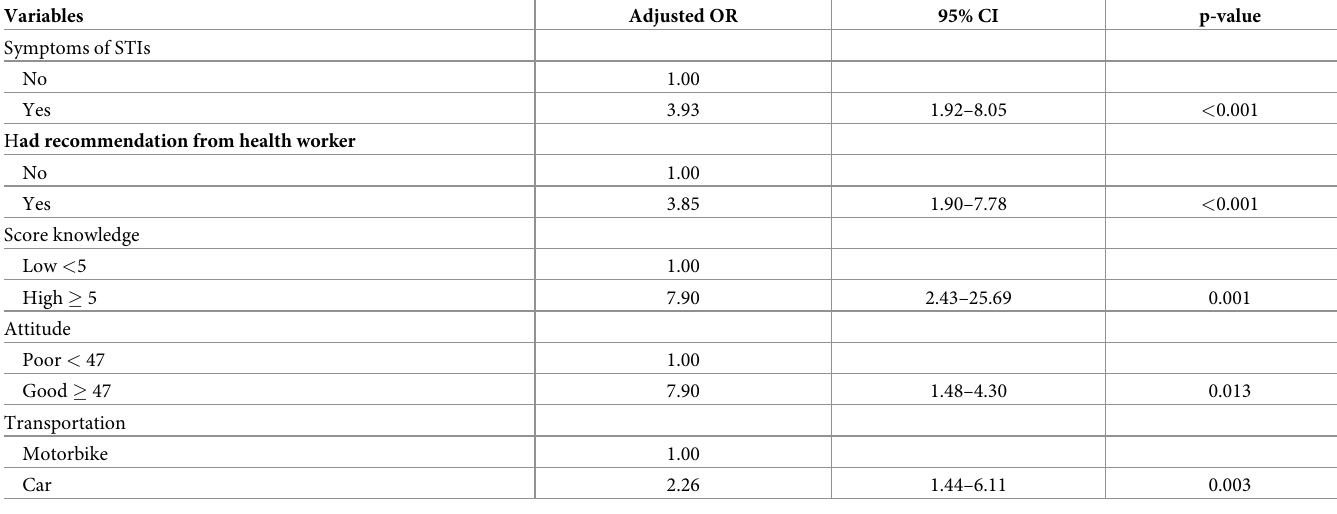
Table 4. Multivariate analyses of factors associated with cervical cancer